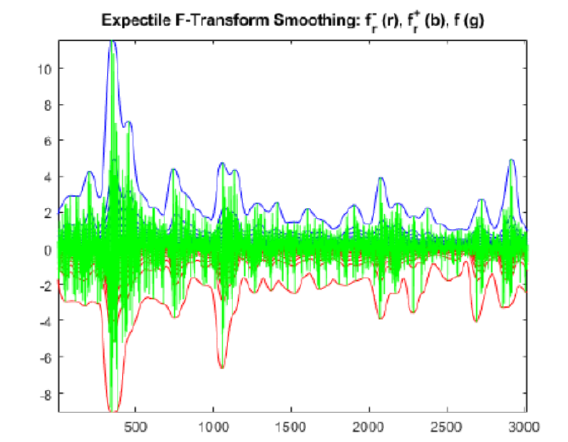
Figure 4. Effects of the expectile smoothing on a twelve years time series of daily returns of the Figure 4: E⁄ects of the expectile smoothing on a twelve years time series of S&P500 daily returns of the S&P500 index.